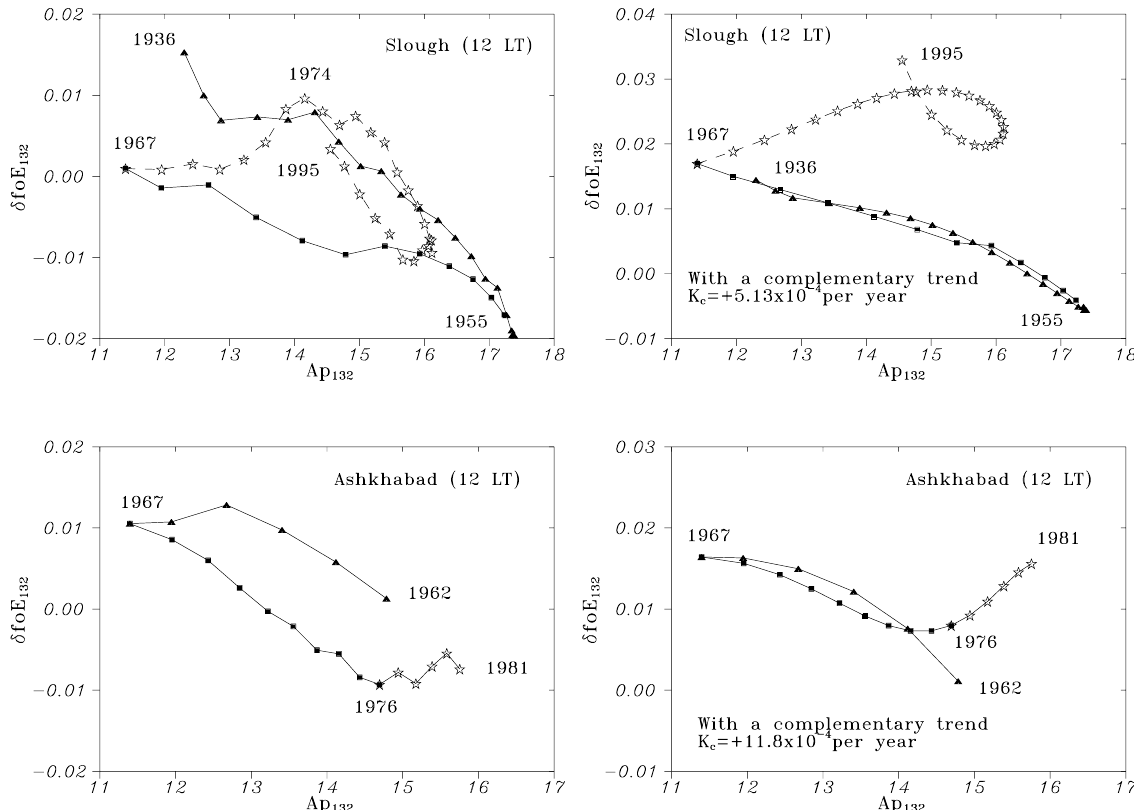
Fig. 3. Two stations illustrating the “natural” inverse type of δ fo E 132 versus Ap 132 dependence during 1936–1967 on Slough and 1962– 1975 on Ashkhabad (left-hand panel). Right-hand panels show the same dependencies after applying the complementary trends. Note the tightening of the two branches in the δ fo E 132 versus Ap 132 dependence before the “break down” effect